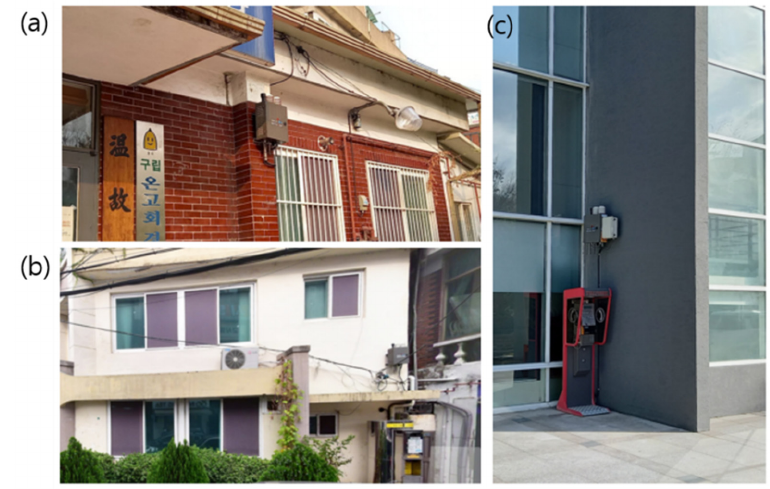
Figure 3. Sensor boxes in ( a ) Changsin-Dong, ( b ) Myeongryun-Dong, and ( c ) Doksan library stations that exhibited extreme temperatures.